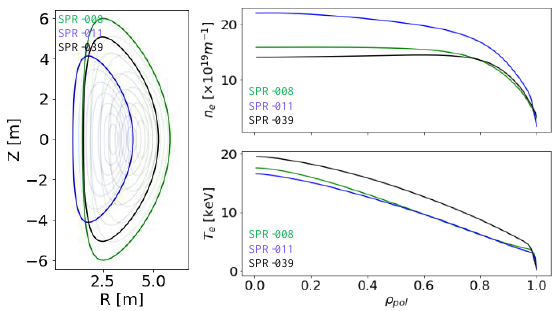
Fig. 5 : Equilibria, density, and temperature profiles for SPR- 008, SPR-011 and SPR-039